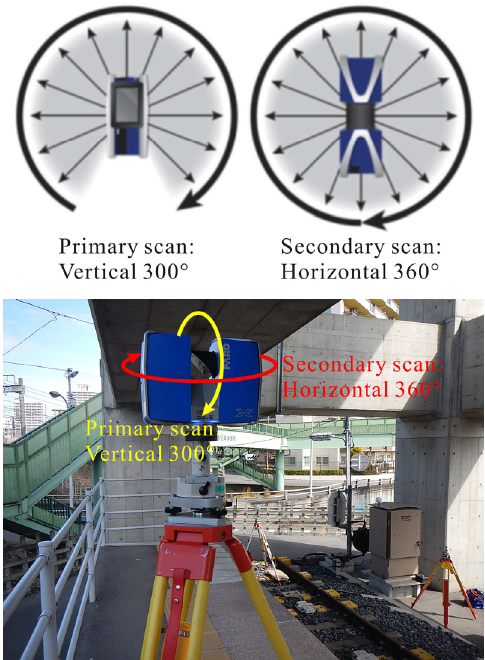
Figure 8. Primary and secondary scans of Focus3D X 330